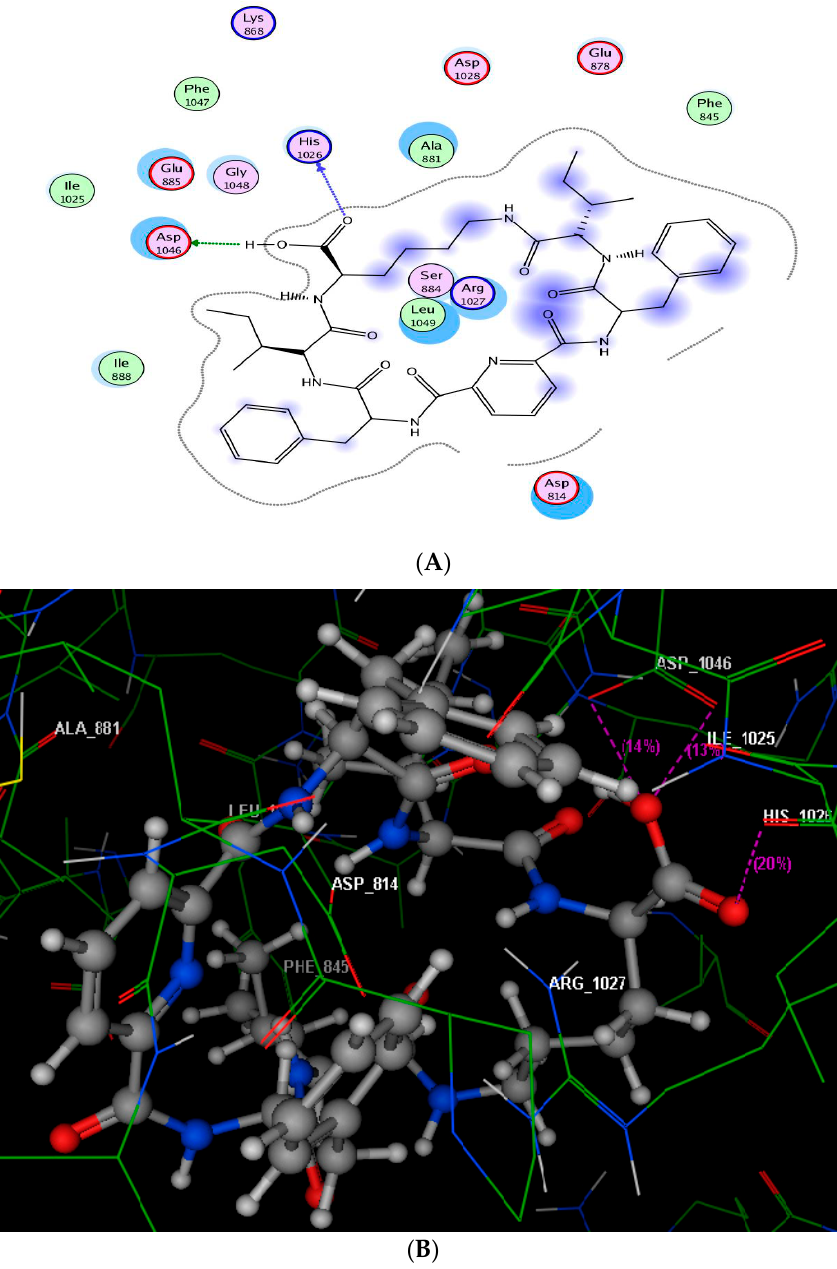
Figure 5. Docking solution for 5c in the active site of VEGFR-2; ( A , B ) showing 2D and 3D ligand-receptor interactions (hydrogen bonds are illustrated as arrows; C atoms are colored gray, N blue and O red).